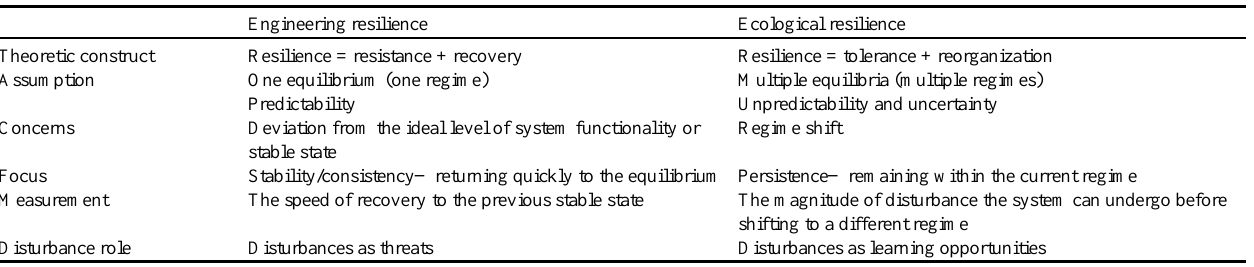
Table 1 . Differences between engineering resilience and ecological resilience.